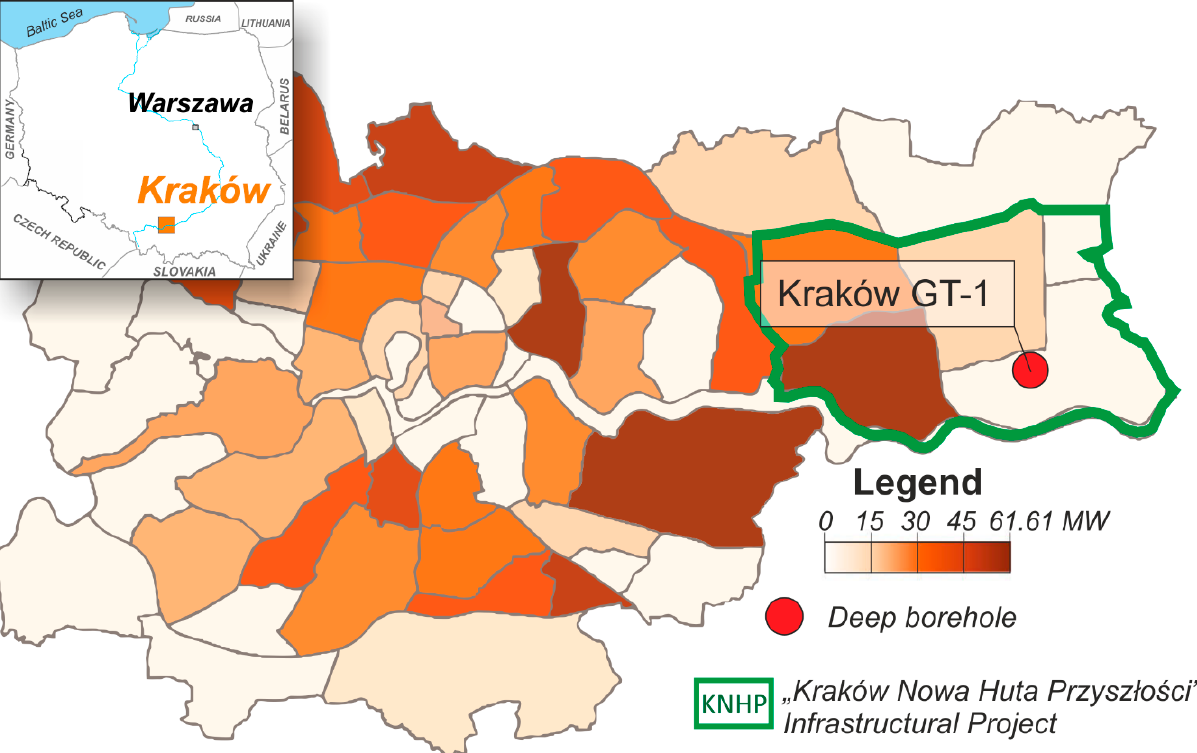
Figure 1. Expected future demand for thermal power in development areas based on the “Study of the Conditions and Directions of Spatial Development for Krakow” (adapted with permission from ref. [21] Copyright 2021 MPEC S.A., modified by M. Hajto).